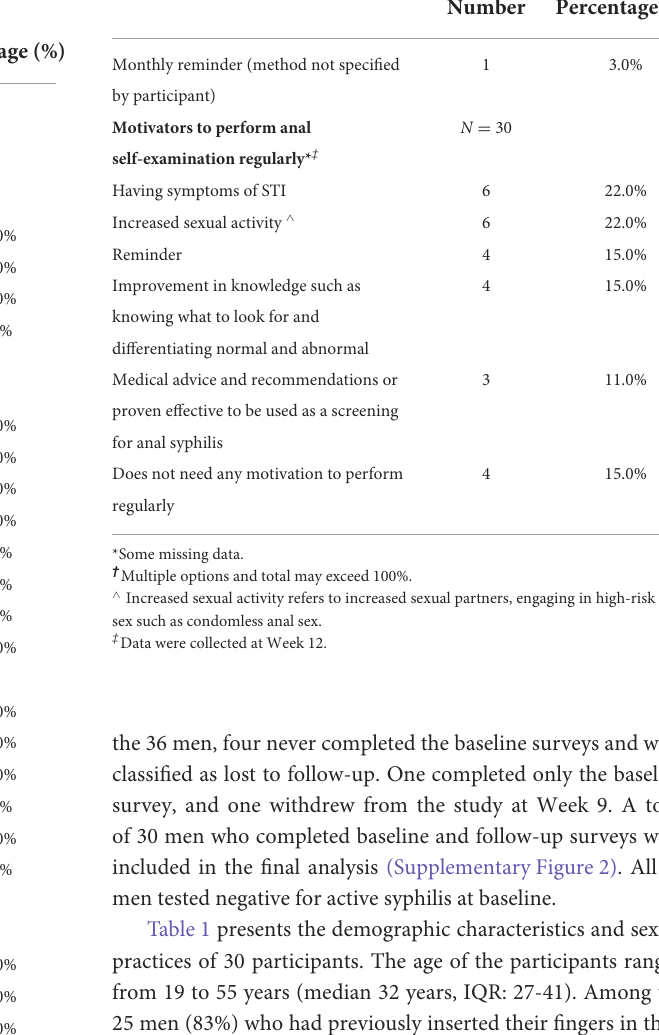
TABLE 2 Sexual practices and anal self-examination including motivators and views of ways to improve adherence to anal